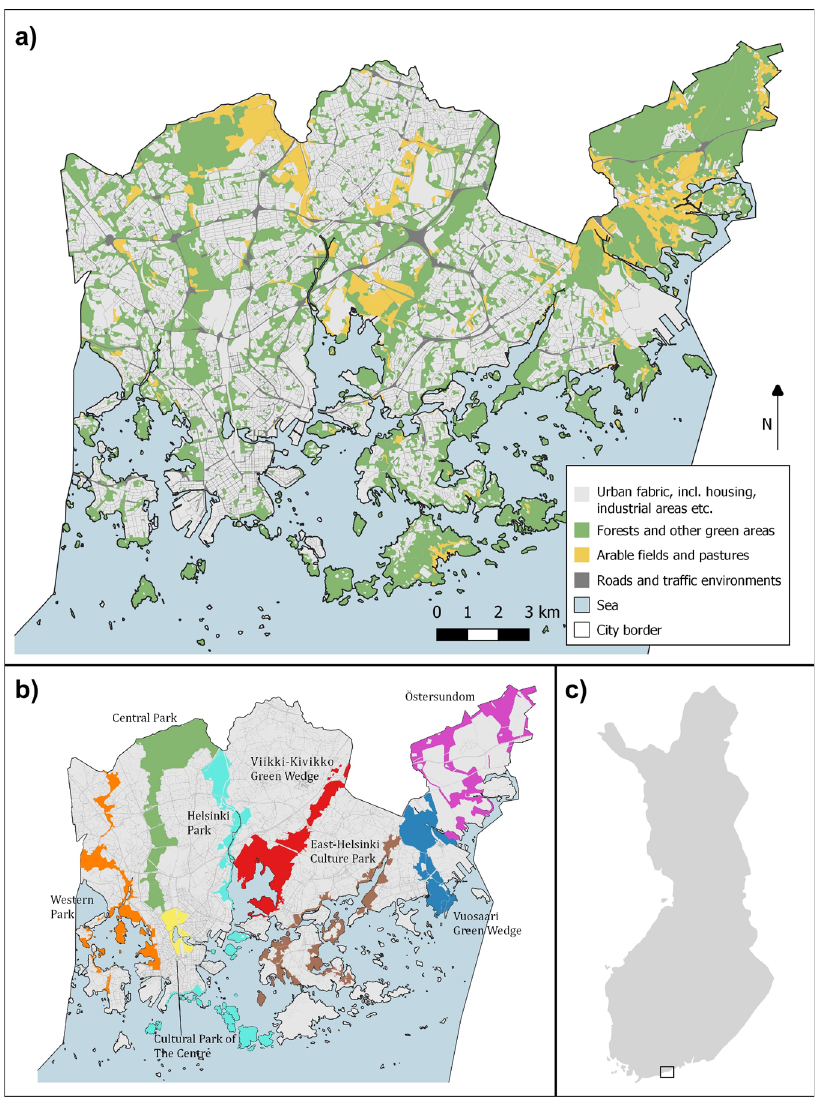
Fig. 1 Map of the city of Helsinki. a A simpli fi ed depiction of broad urban land use and land cover types and b with the green wedges important to the analyses highlighted based on the Urban Atlas 2018 68 . Study area location with respect to Finland is shown in c